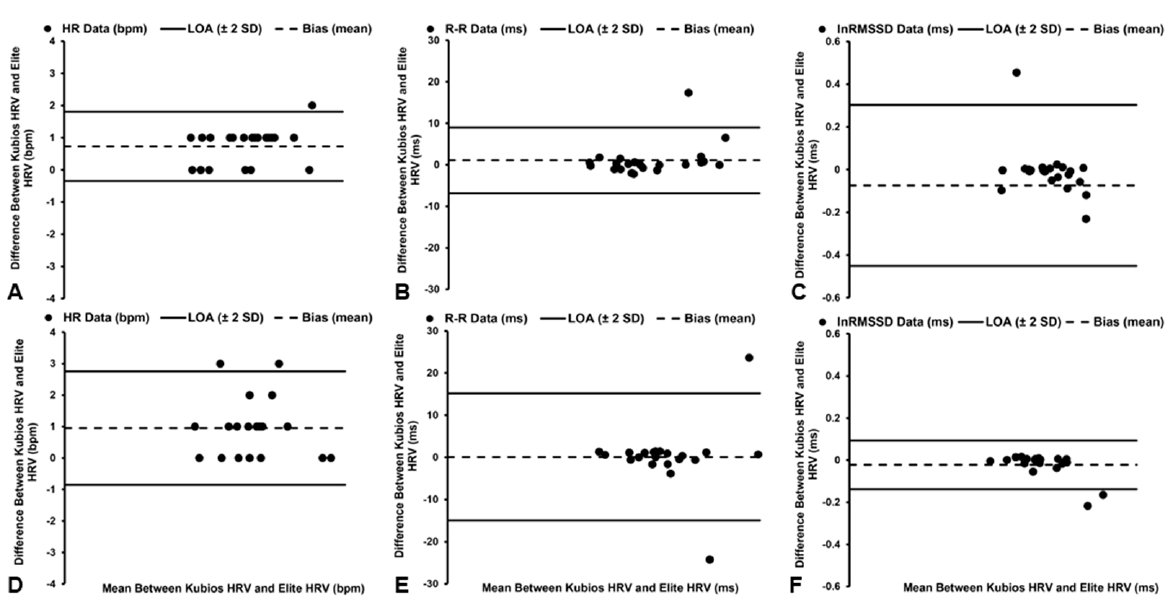
Figure 3. Bland–Altman plots demonstrating the mean bias and limits of agreement (LoA) of heart rate (HR, A ), R–R interval ( B ), and natural log of root mean square of successive differences (lnRMSSD, C ) data in the supine position and the mean bias and limits of agreement (LoA) of HR ( D ), R–R interval ( E ), and lnRMSSD ( F ) data in seated position when utilizing Very Low artifact-correction level.